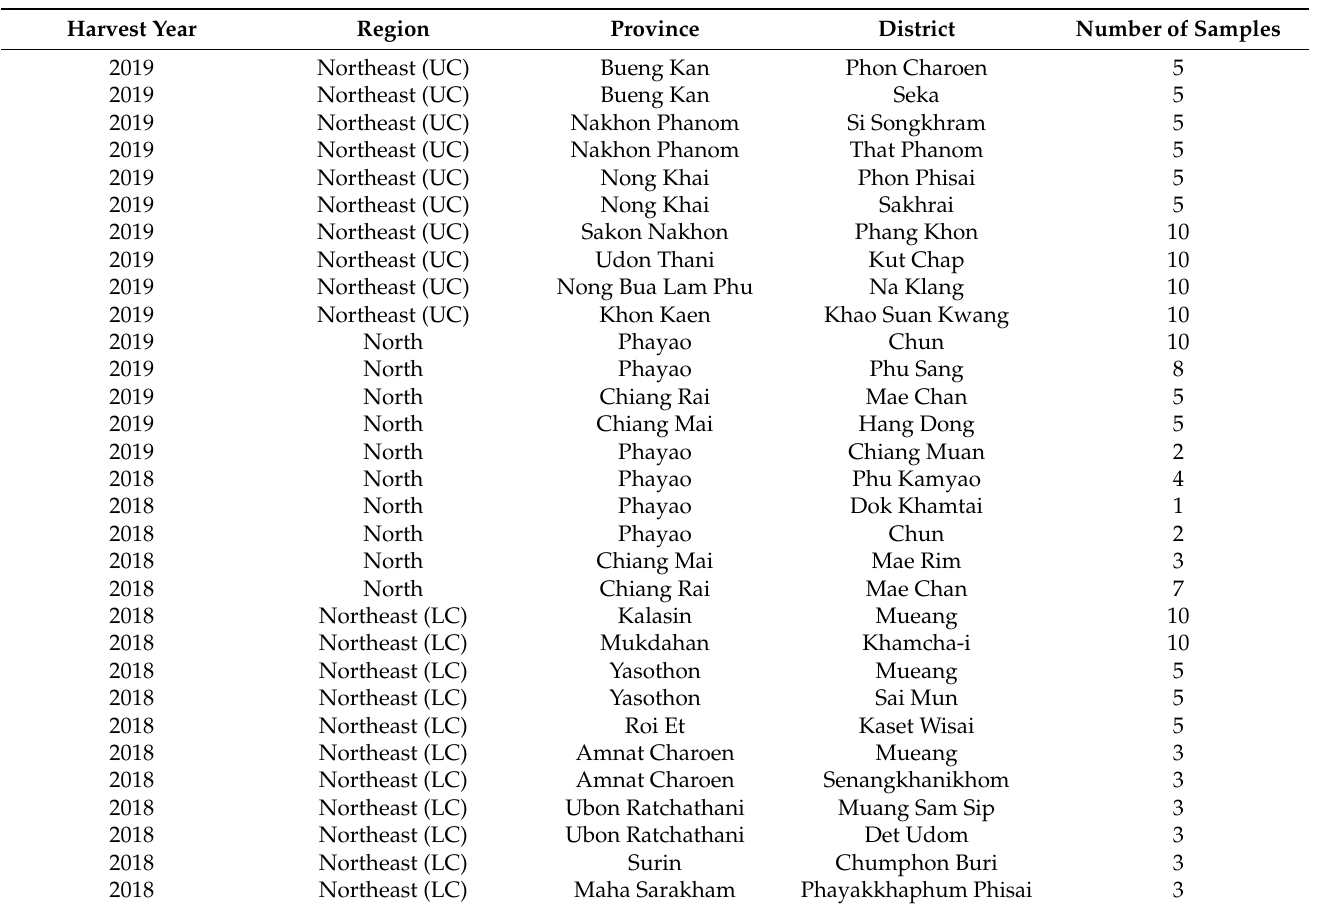
Table 1. Thai Hom Mali rice sample